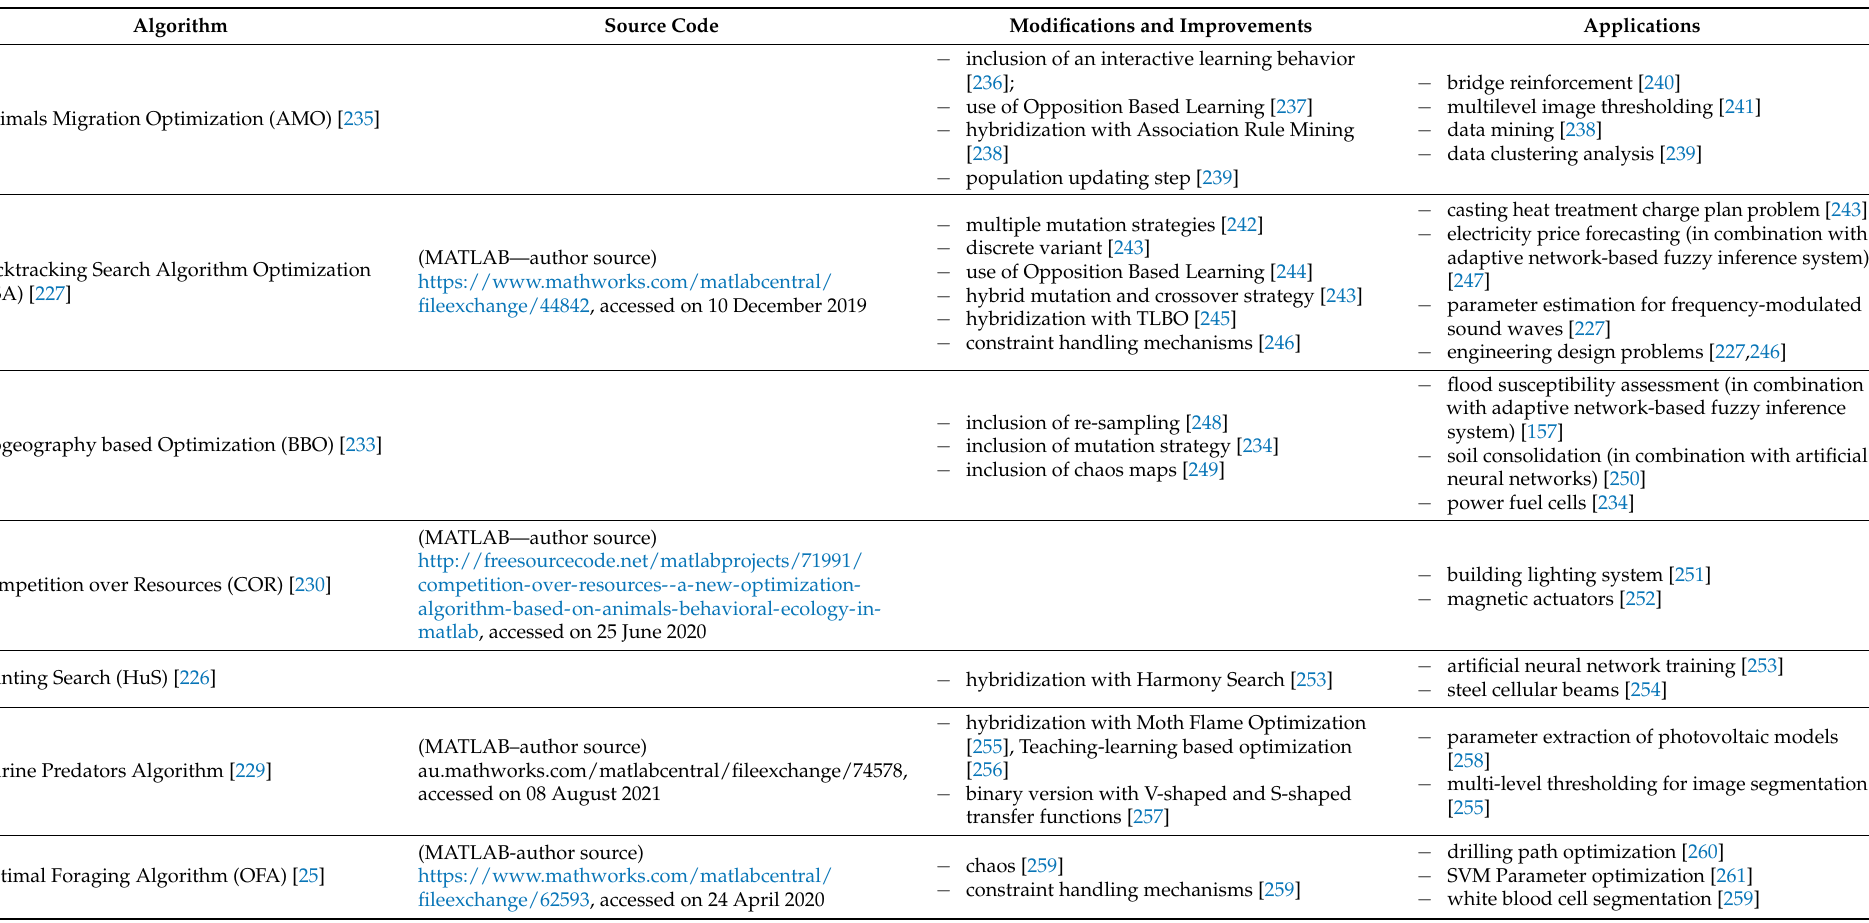
Table 3. Improvements and applications for metaheuristics inspired from general behavior (alphabetically